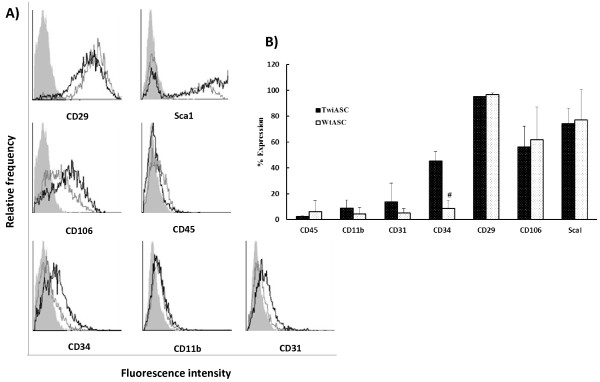
Cell surface phenotype analysis of TwiASCs and WtASCs. A) Cells were analyzed by flow cytometry for MSC surface markers CD29, Sca1 and CD106; hematopoietic markers CD34 and CD45; phagocytic lineage marker CD11b; and endothelial marker CD31. Gray filled: isotype control; gray line: WtASCs; black line: TwiASCs. B) The percentage expression of each surface marker. All cells were analyzed at passage 3. # means P< 0.05 vs TwiASCs for CD34 (t-test, n=3).